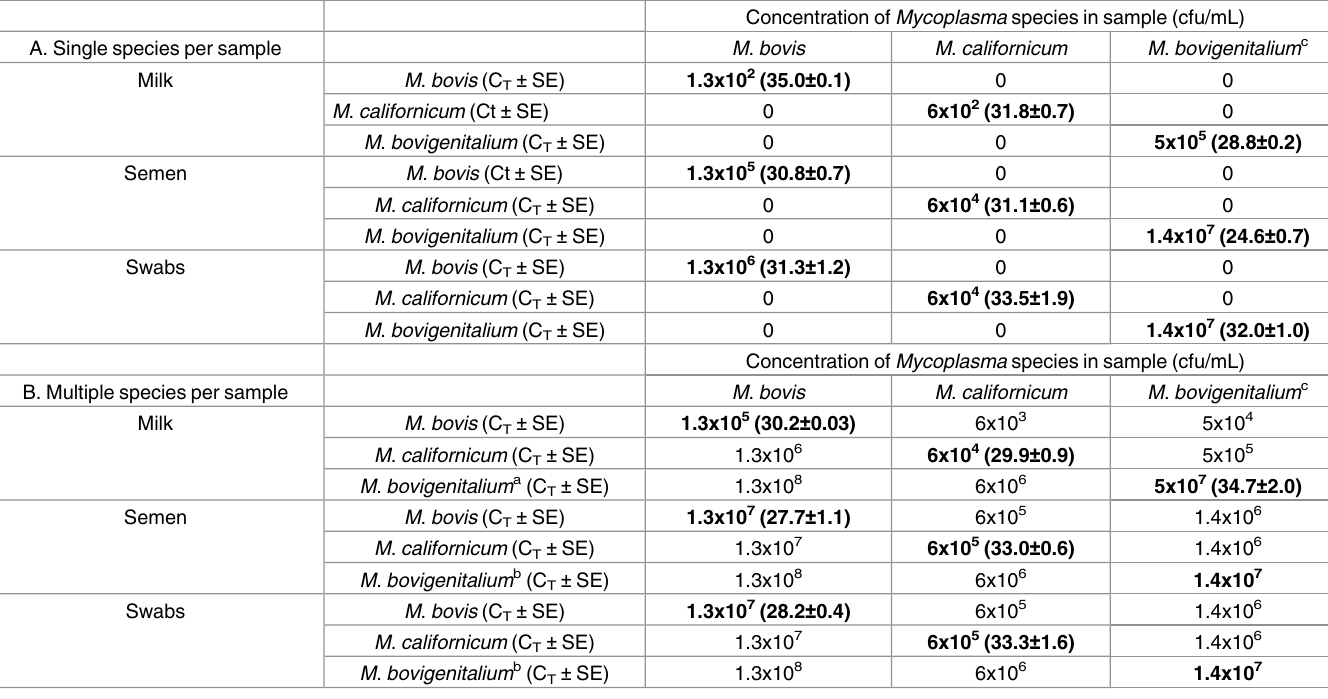
Table 3. Multiplex probe PCR limit of detection (cfu/mL) and associated mean cycle threshold ( ± SE)for different spiked sampletypes. Singletarget species present per sample (A) and multipletarget species present per sample (B) and the concentration of each target species in the sample at the limit of detection(read from left to